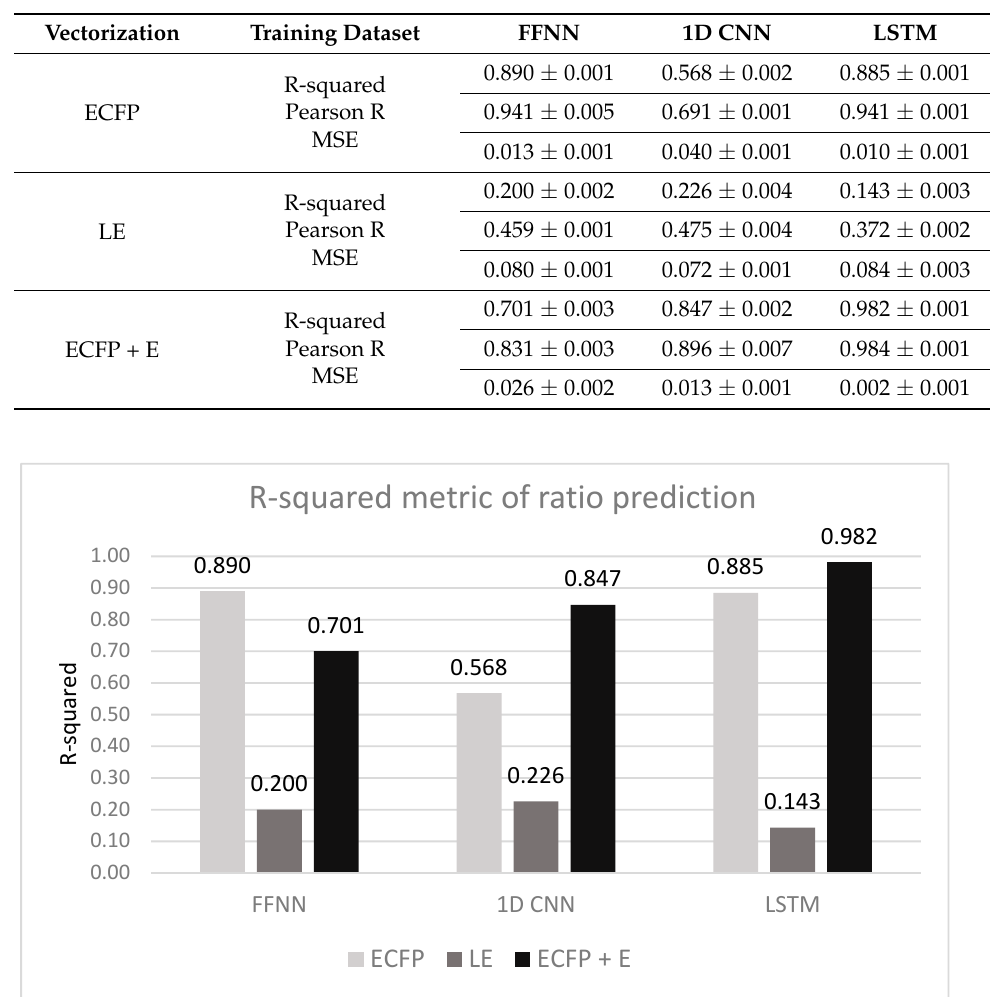
Table 6. Evaluation results of task No. 2.